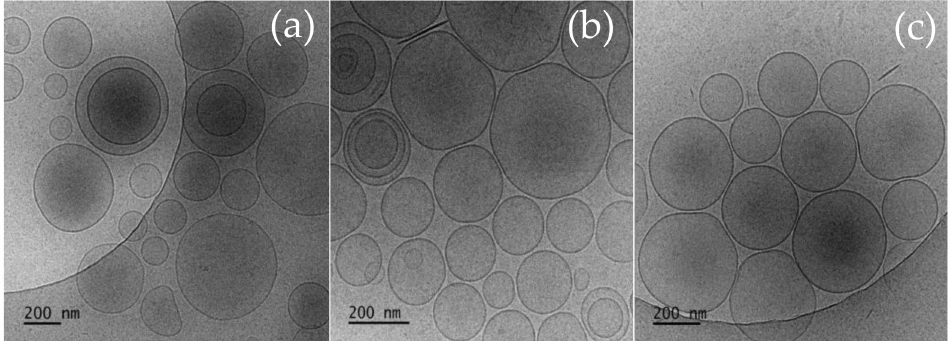
Figure 2. Cryo-TEM images of niosomes composed of Tw60:Sp60:Chlo 3.5:3.5:3 (mol:mol): ( a ) Empty niosomes; ( b ) Curcumin solely loaded vesicles; and ( c ) Curc/GS-co-loaded niosomes. Bars = 200